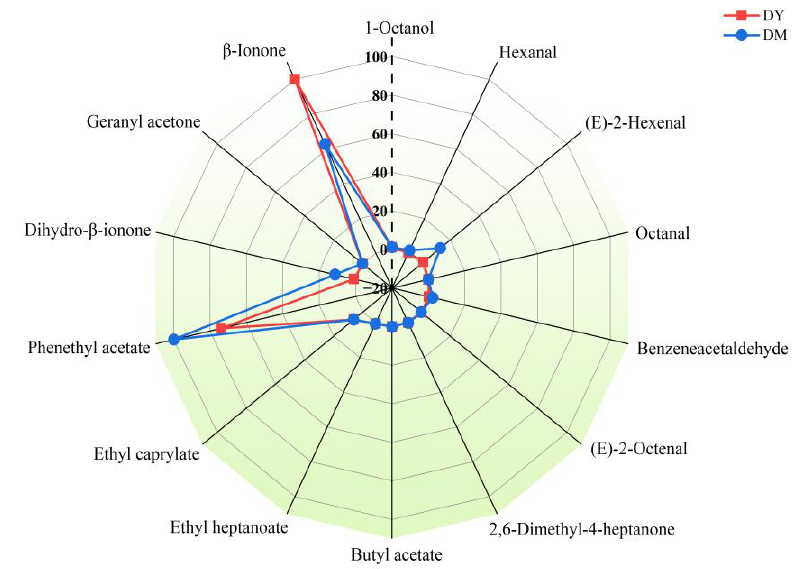
Figure 5. rOAV radar map of volatile aroma compounds. Table 3. rOAV for volatile aroma compounds in D. delavayi fruit of varying maturities.